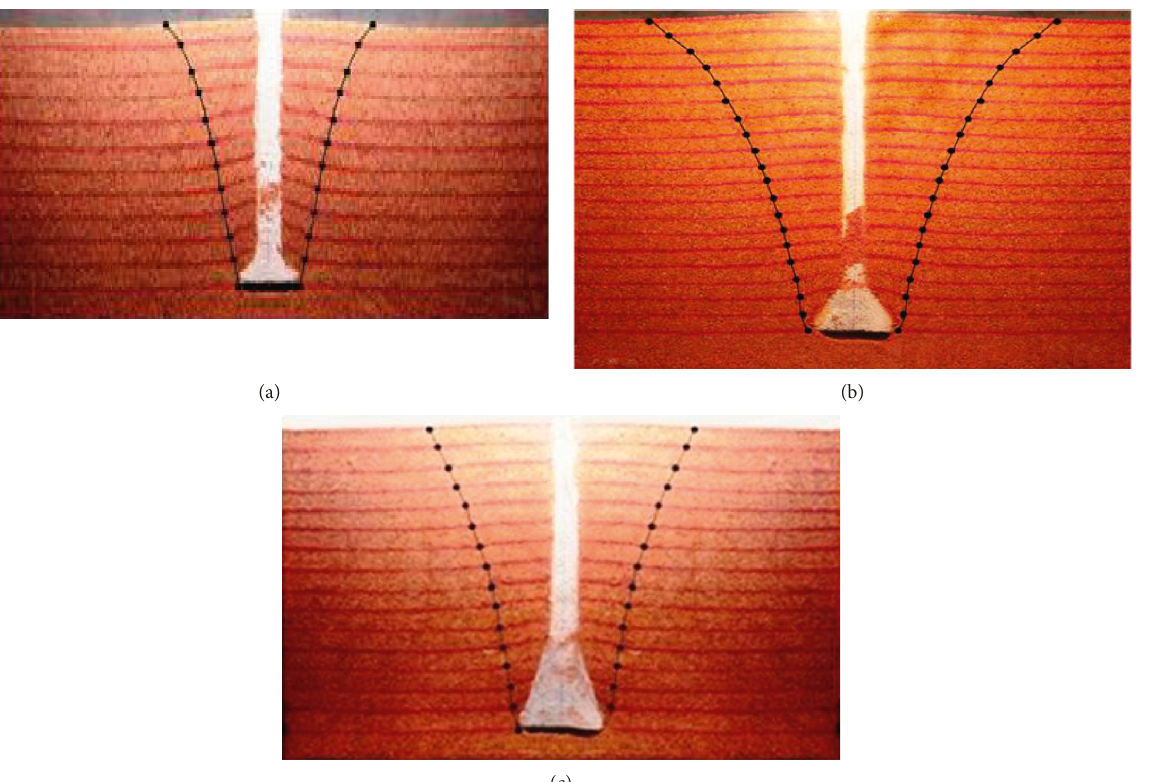
Figure 5: Pictorial view of nonlinear failure surfaces on both the sides of (a) panel 2D:45-0.46-4-( S panel 2D:72-0.33-4-( S I